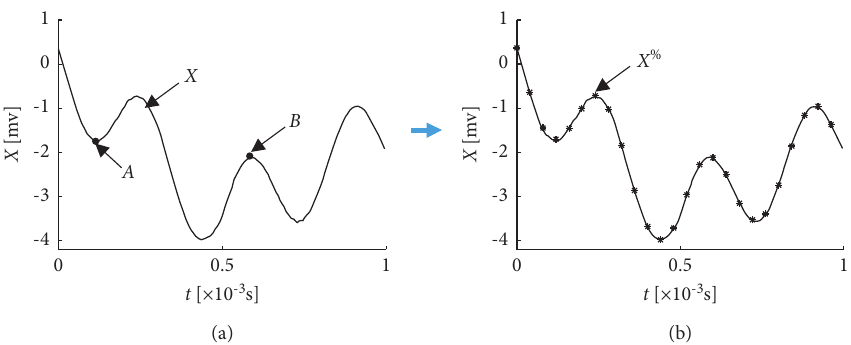
Figure 2: Downsampling sequence: (a) the original signal (X) and (b) 􏽥 X in